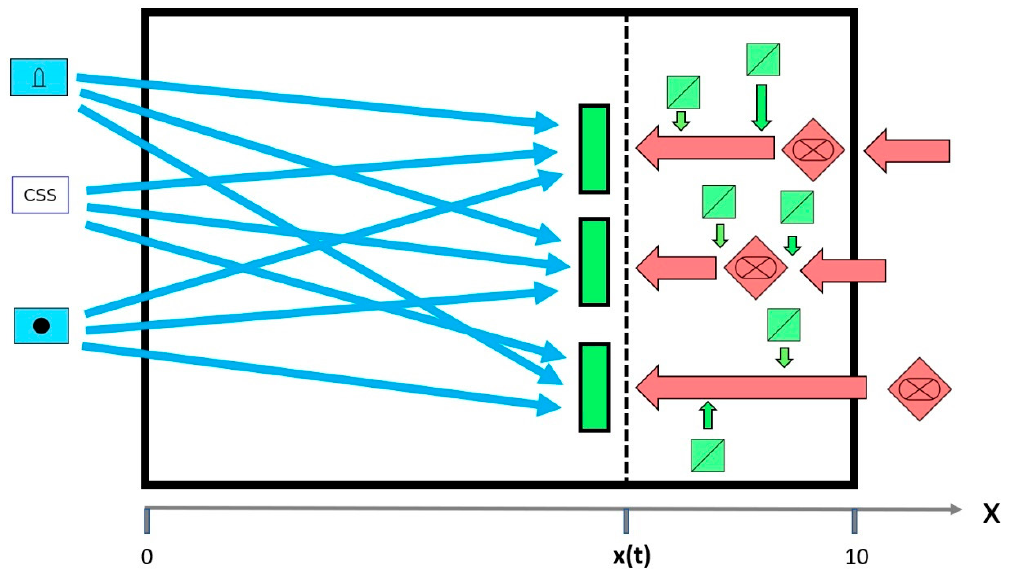
Figure 1. The war map of the country GREEN at time t. Explanations are given in the main text. The frontline x(t) = 6.8. Compare Figure 2, which represents another case, where the frontline at the same point in time has another location.